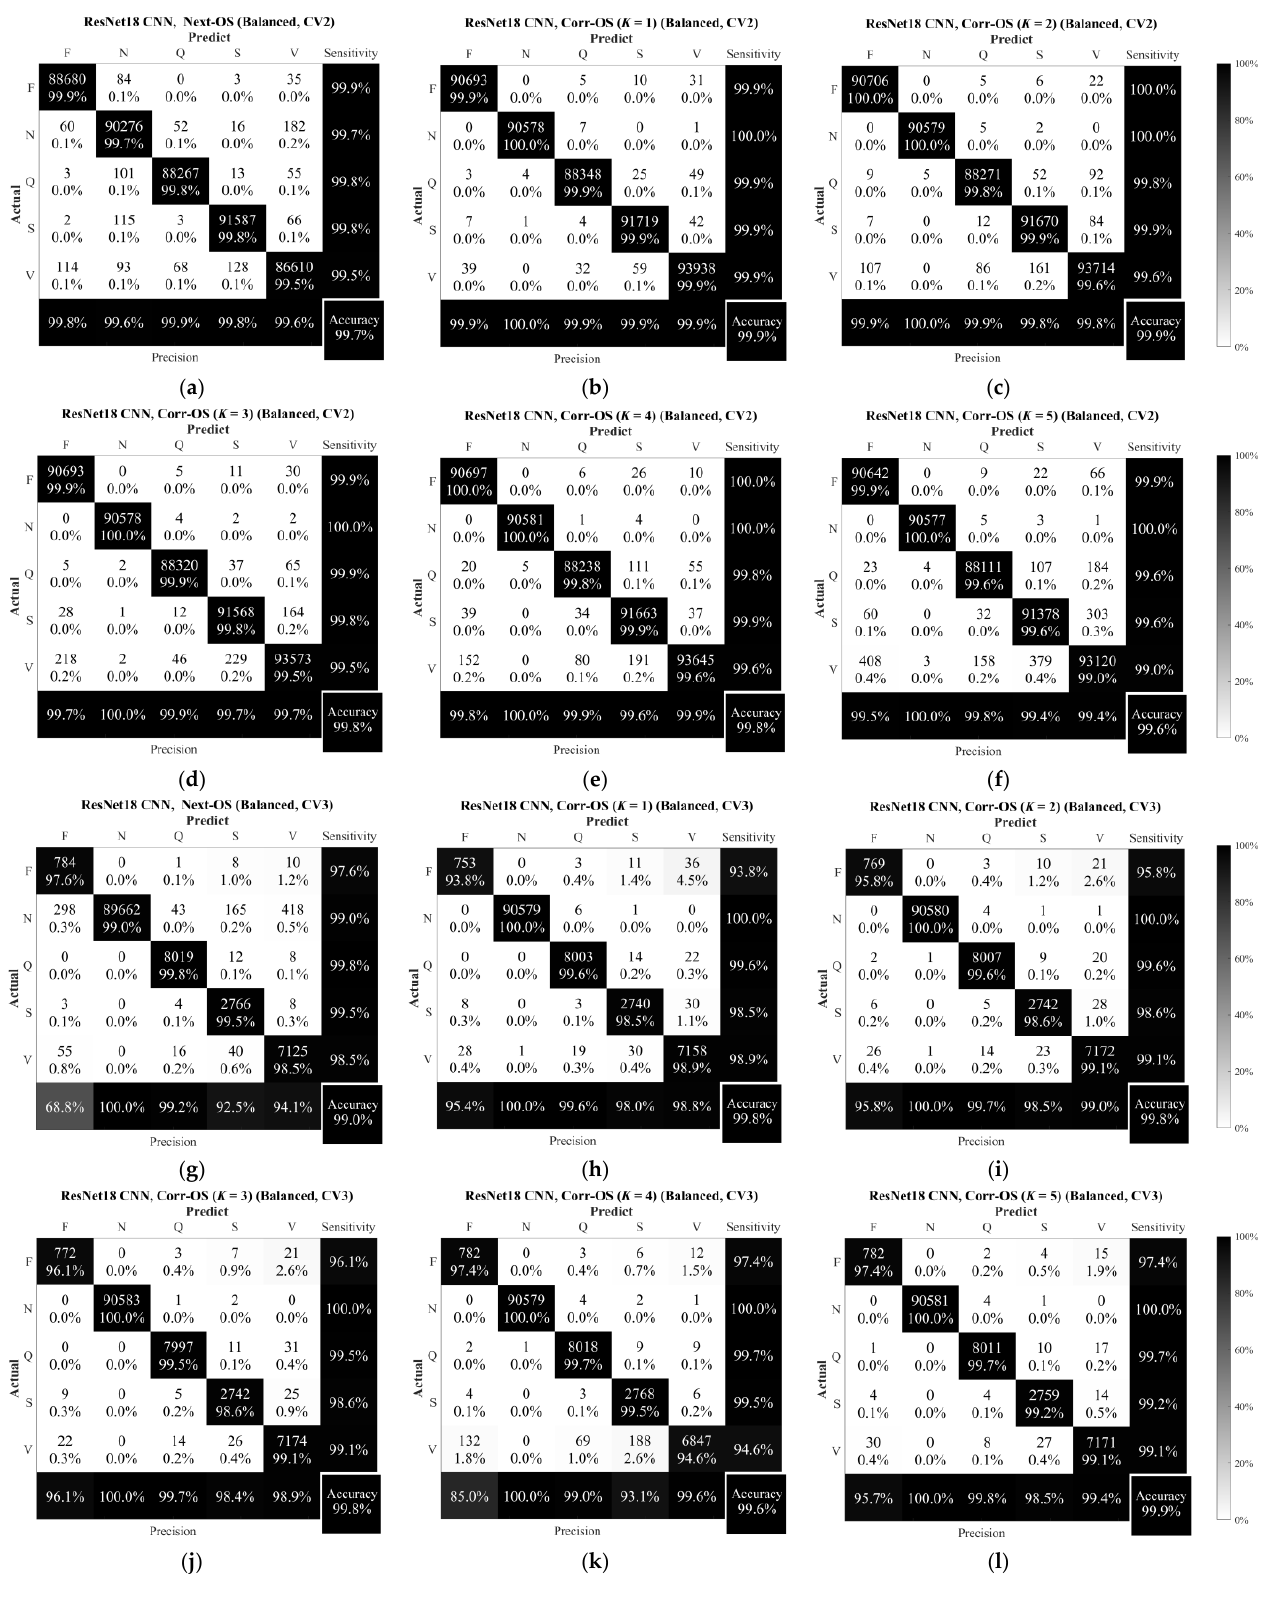
Figure A3. Confusion matrix of ResNet18 using CV2 for ( a ) Next-OS, ( b ) Corr-OS ( K = 1), ( c ) Corr-OS ( K = 2), ( d ) Corr-OS ( K = 3), ( e ) Corr-OS ( K = 4), and ( f ) Corr-OS ( K = 5); using CV3 for ( g ) Next-OS, ( h ) Corr-OS ( K = 1), ( i ) Corr-OS ( K = 2), ( j ) Corr-OS ( K = 3), ( k ) Corr-OS ( K = 4), and ( l ) Corr-OS ( K = 5).